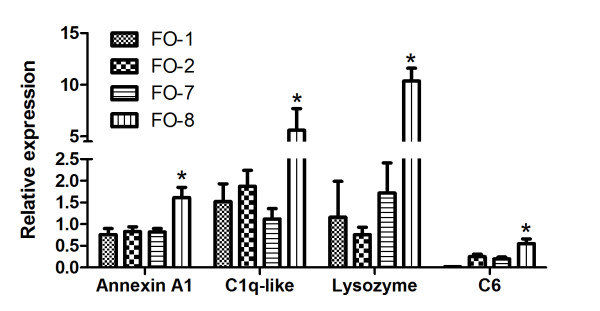
Markers of inflammation expressed in the head kidney of Atlantic salmon injected with different oil-based vaccines. Quantitative real-time RT-PCR (qPCR) expression of genes identified as upregulated by microarray. FO-1 = A. salmonicida (sc); FO-2 = A. salmonicida (6 × sc); FO-7 = M. viscosa (sc); FO-8 = M. viscosa (6 × sc). Gene expression ratios normalized to Elongation factor 1α (EF1α). Error bars = standard error (SE), n= 7. *p < 0.05.